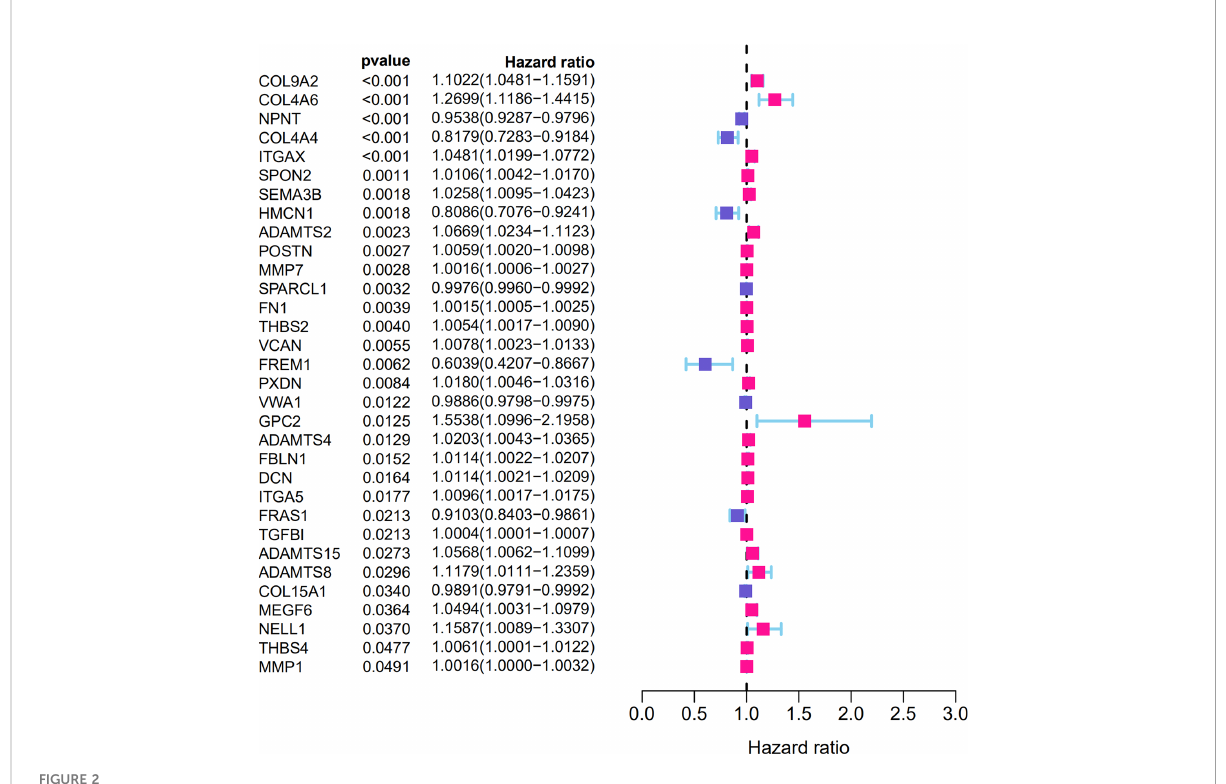
FIGURE 2 The BM genes with prognostic signi fi cance in